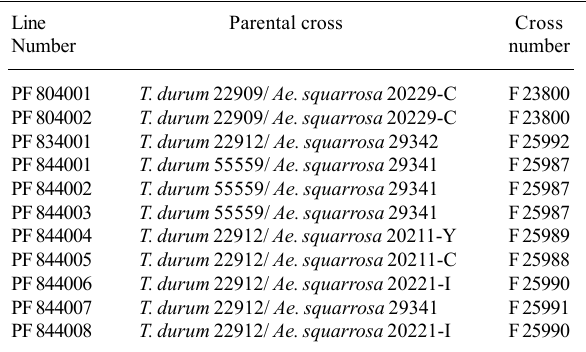
Table III - Fertile new synthetic lines obtained from the crosses presented in Table